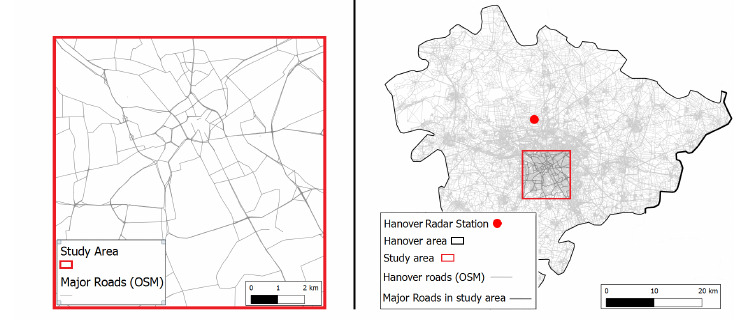
Figure 2. The 10 km × 10 km study area for the motion estimation algorithms. OSM, Open Street